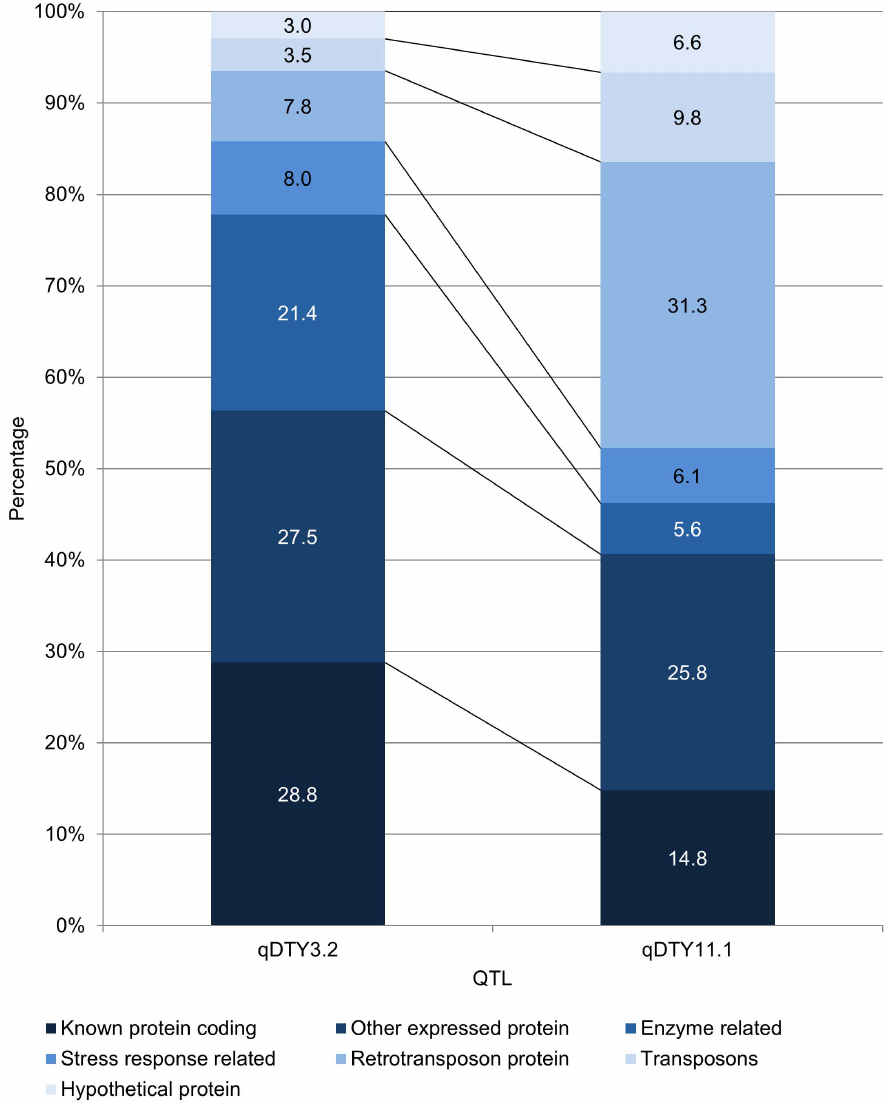
Figure 6. Comparison of gene content of qDTY 3.2 and qDTY 11.1 based on percentage of genes belonging to seven gene classes within the two QTLs.